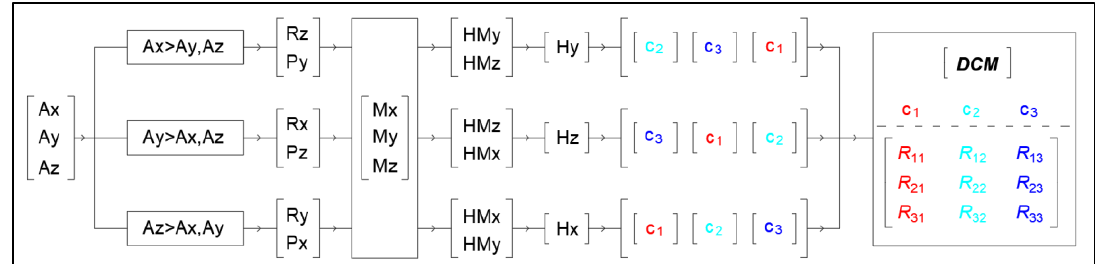
Figure 1. Analytical flowchart for calculating direction cosine matrix ( DCM ) by using accelerometer and magnetometer output.